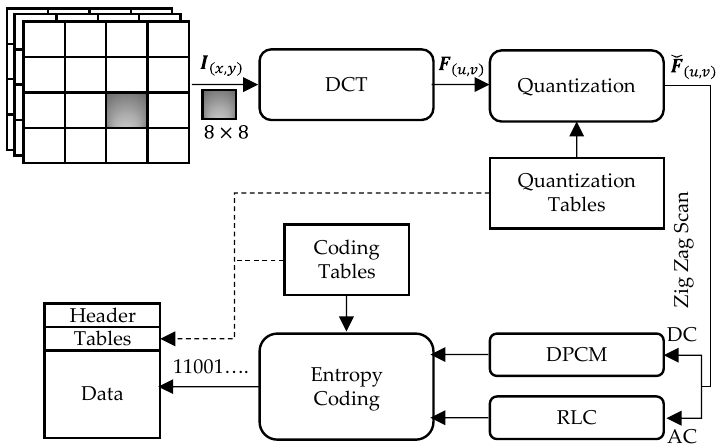
Figure 2. An illustration of the JPEG image compression algorithm.